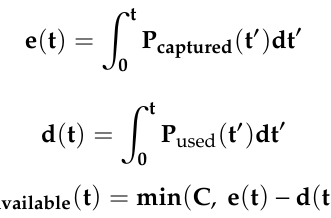
Figure 4. Classification of the surveyed AI techniques .